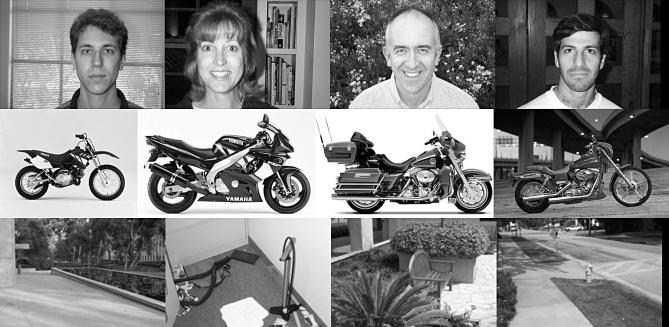
Sample Pictures from the Caltech DatasetsThe top row shows examples of faces (all unsegmented), the middle row shows examples of motorbikes (some are segmented, others are not), and the bottom row shows examples of distractors.